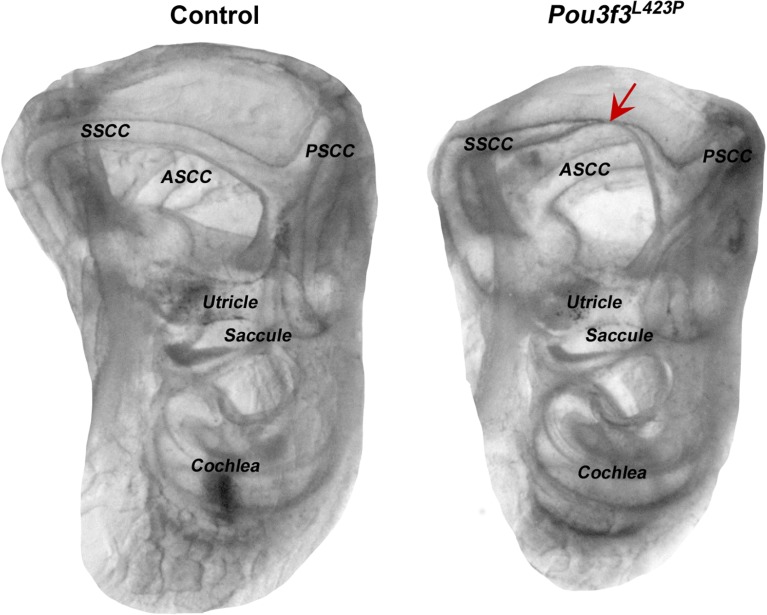
Morphological analysis of the inner ears of line Pou3f3L423P.Morphological analysis of the inner ears using the whole mount clearing method showed abnormal superior semi-circular canal formation in the homozygous mutants of line Pou3f3L423P. Left picture shows a control inner ear with normal semi-circular canals. Right picture shows the smaller inner ear of a Pou3f3L423P homozygous mutant animal with abnormal superior semi-circular canal formation. Red arrow shows the constriction of the superior semi-circular canal. SSCC: superior semi-circular canal, PSCC: posterior semi-circular canal, ASCC: anterior semi-circular canal.